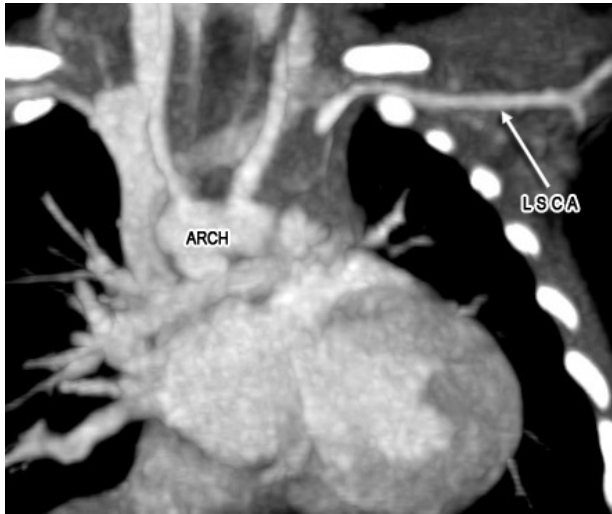
Fig. 2 – CT scan images showing isolated left subclavian artery arising from left pulmonary artery with thrombosed ductal tissue intervening them and filling by collaterals.